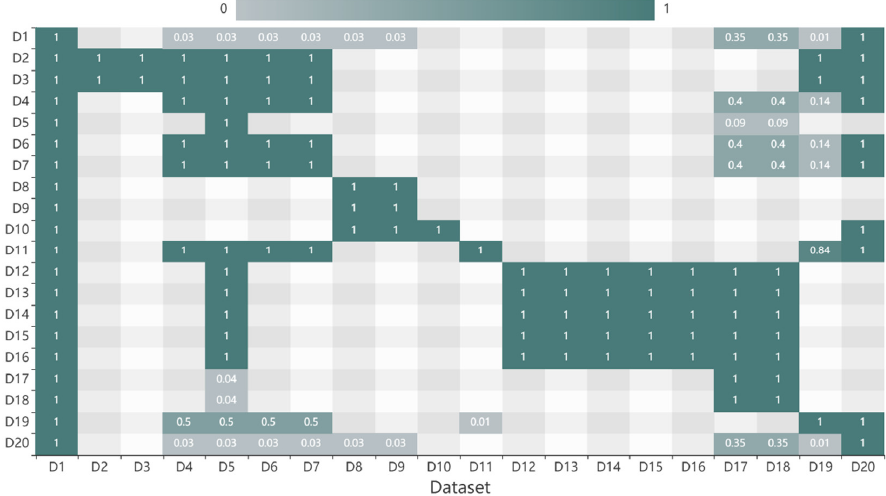
Figure 6. Spatial similarities of datasets.